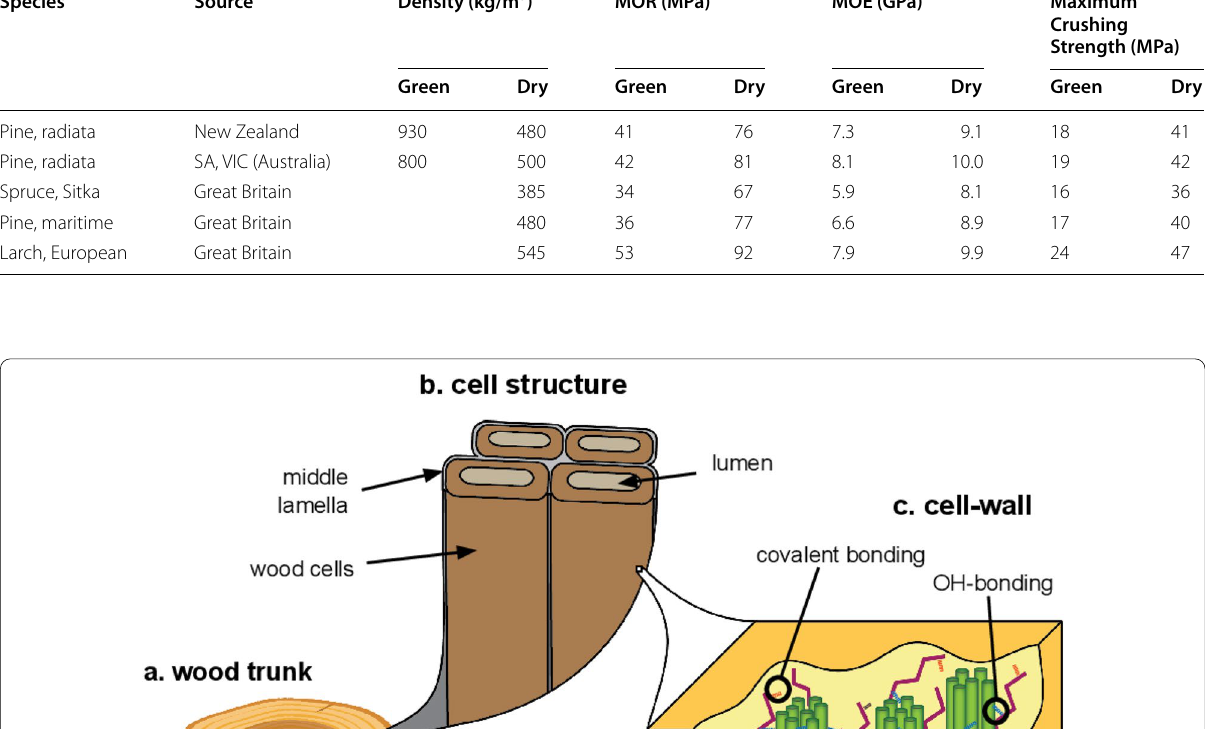
Table 1 Species and material properties of timber [7] Species